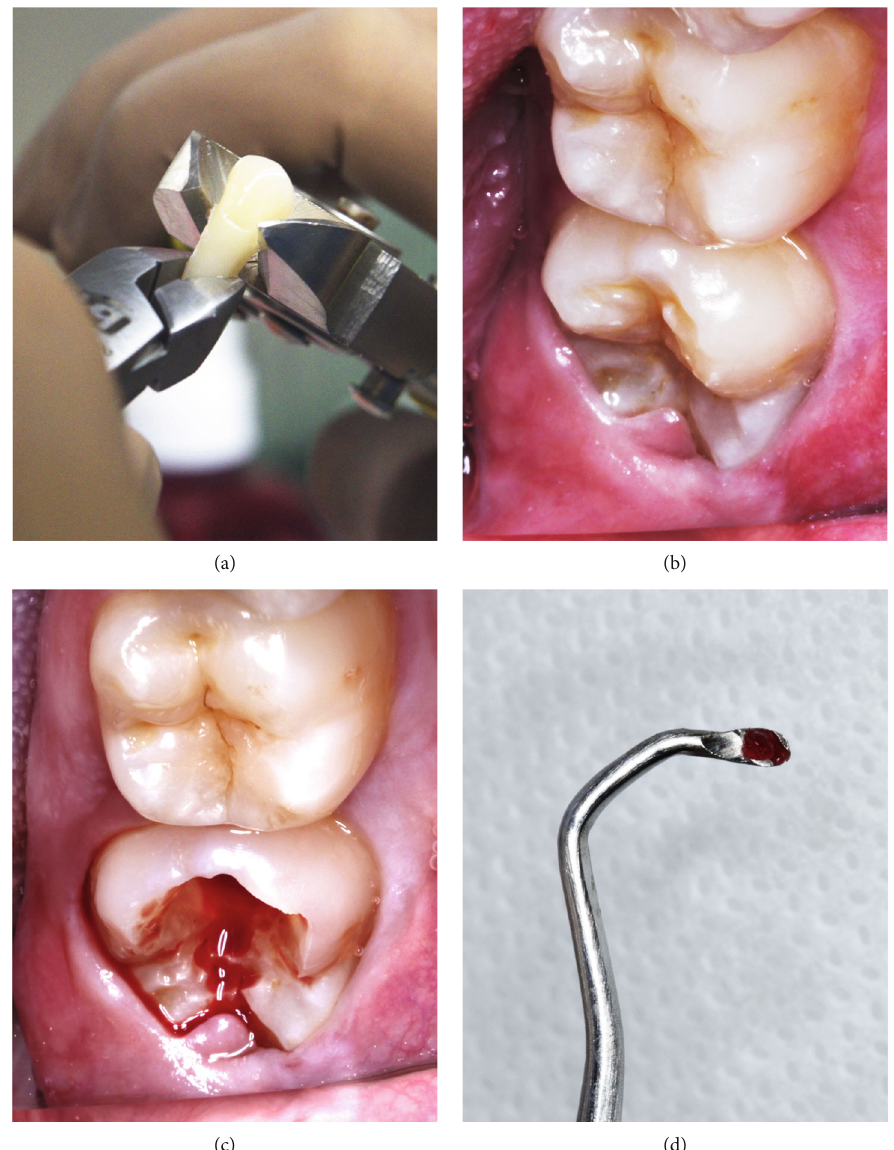
Figure 1: Comparison between collection methods. (a) Postextraction coronary section. (b) Sound crown. (c) Coronary access. (d)